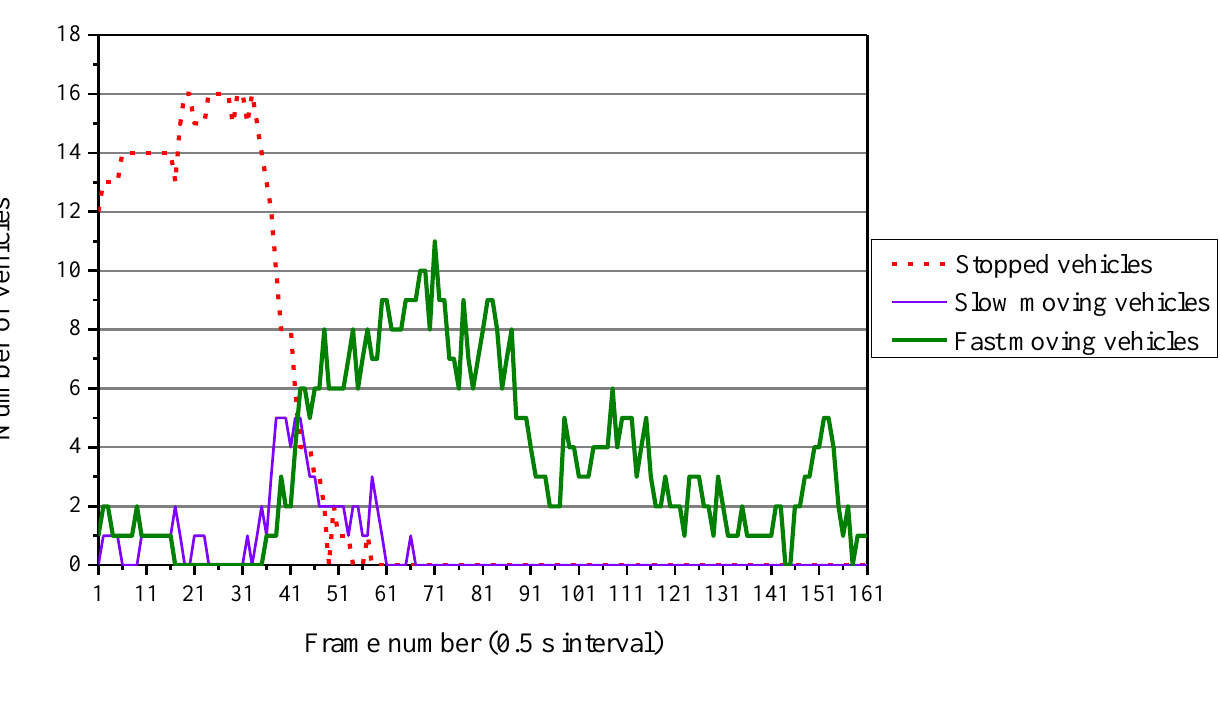
Figure 17. Fluctuations of the numbers of